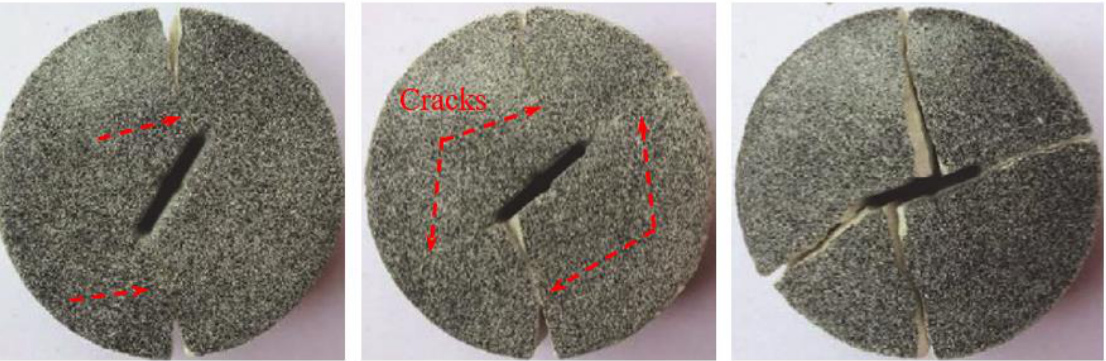
Figure 25. The failure mode for Brazilian discs with cracks of different angles in Luo’s research [38]; the crack angles are 36°, 54°and 72°, respectively.